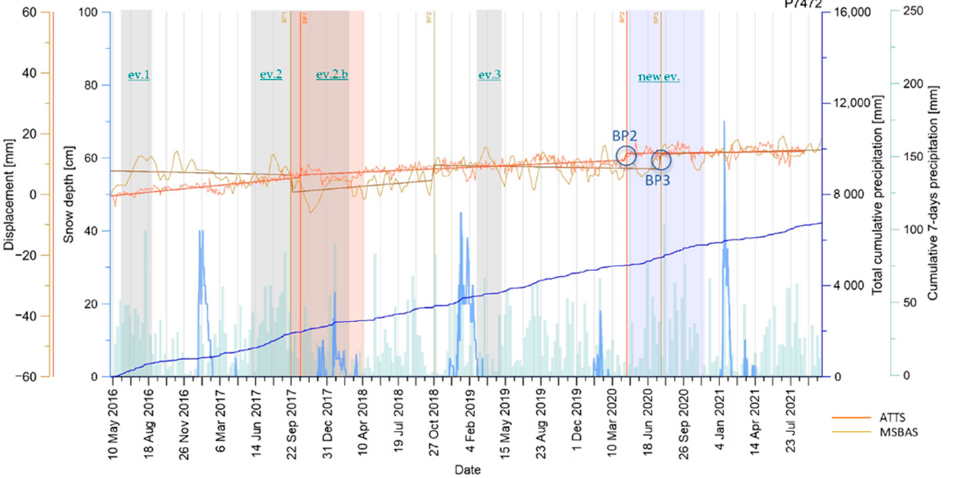
Figure 11. Horizontal (EW) displacement time series correlation of ATTS (red) against MSBAS (gold) for slab B. Evaluation of Trends and BPs of point n. P7472 plotted against total cumulative precipitation (dark blue line), cumulative 7 ‐ days precipitation (histogram), and snow depth (light blue line).